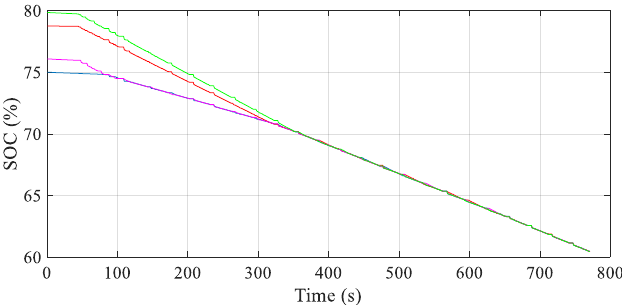
Figure 13. SOC balancing achieved by the proposed SBP. Each line corresponds to the SOC of one of the cells in the considered battery pack.